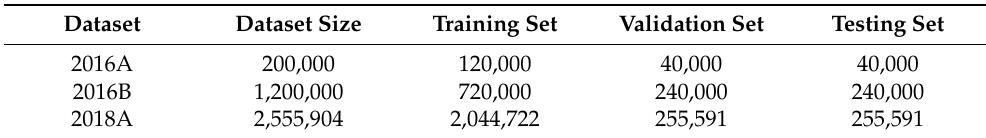
Table 2. Details of the dataset